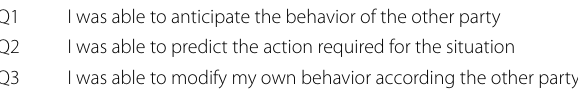
Table 1 Qualitative evaluation questionnaire items